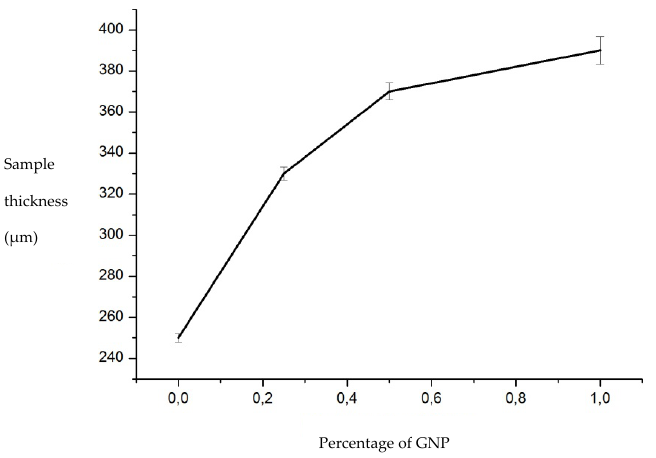
Figure 1. Epoxy/GNP thin film thickness trend (1000 rpm) as GNP concentration varies.